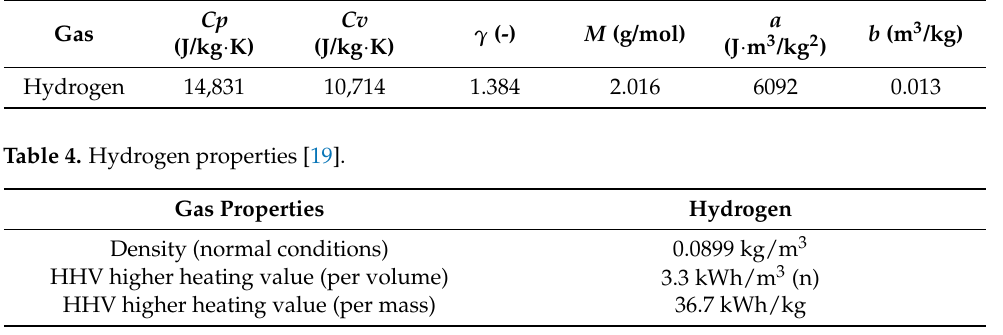
Table 3. Hydrogen constants, van der Waals law [18].